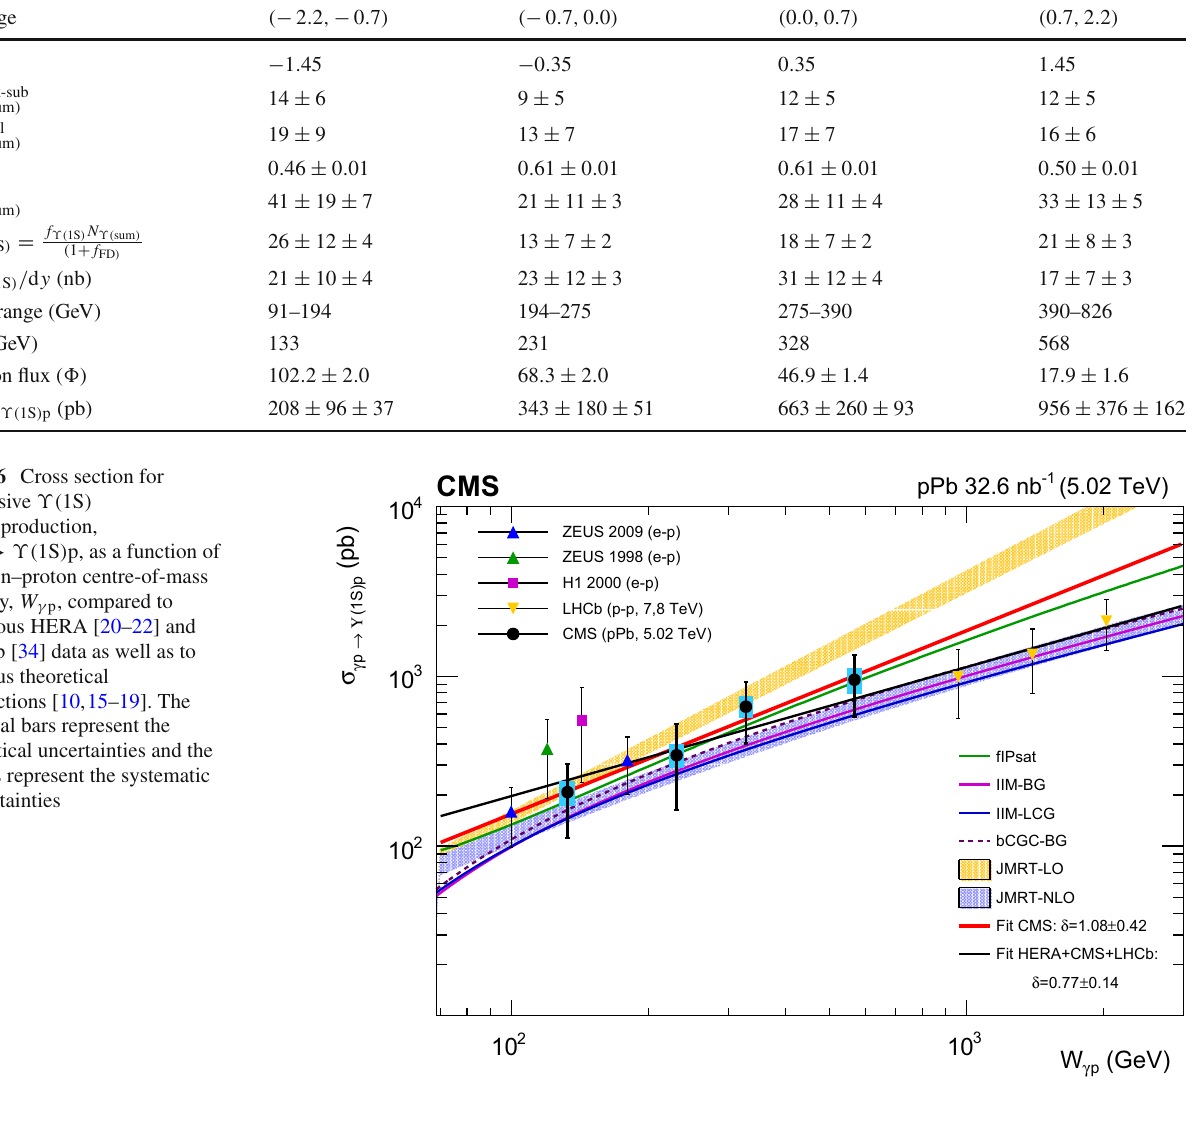
Table 3 Values of the ϒ( 1S ) photoproduction cross section in four subtraction, unfolding, and extrapolation with the A corr factor, respec- tively; N ϒ( 1S ) is the extracted number of ϒ( 1S ) mesons, and (cid:12) is the rapidity y bins, corresponding to four photon–proton W γ p centre-of- mass energy ranges (with central W 0 value obtained following the pro- theoretical effective photon flux (see text). The first (second, if given) √ = 5 . 02TeV. s uncertainty quoted corresponds to the statistical (systematic) compo- cedure outlined in Ref. [62]), in pPb collisions at NN The symbols N back-sub ϒ( , N unfol ϒ( , and N corr ϒ( represent the numbers sum ) sum ) sum ) of ϒ( sum ) = ϒ( 1S ) + ϒ( 2S ) + ϒ( 3S ) candidates after background